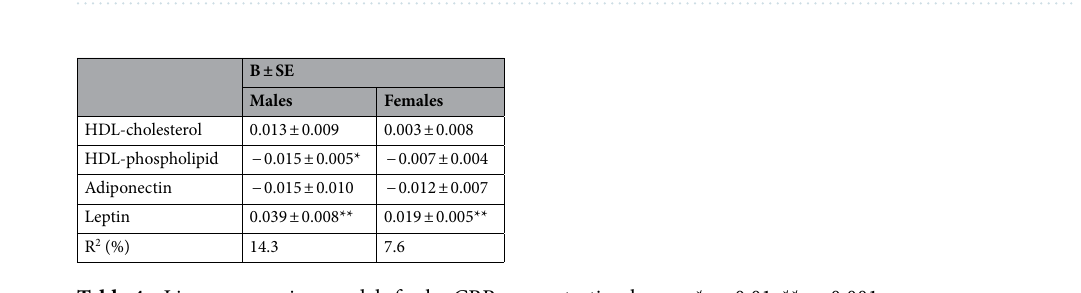
Table 3. Spearman’s correlation between hs-CRP, leptin, adiponectin, HDL cholesterol and HDL phospholipid levels by sex. *p < 0.01; **p < 0.001.